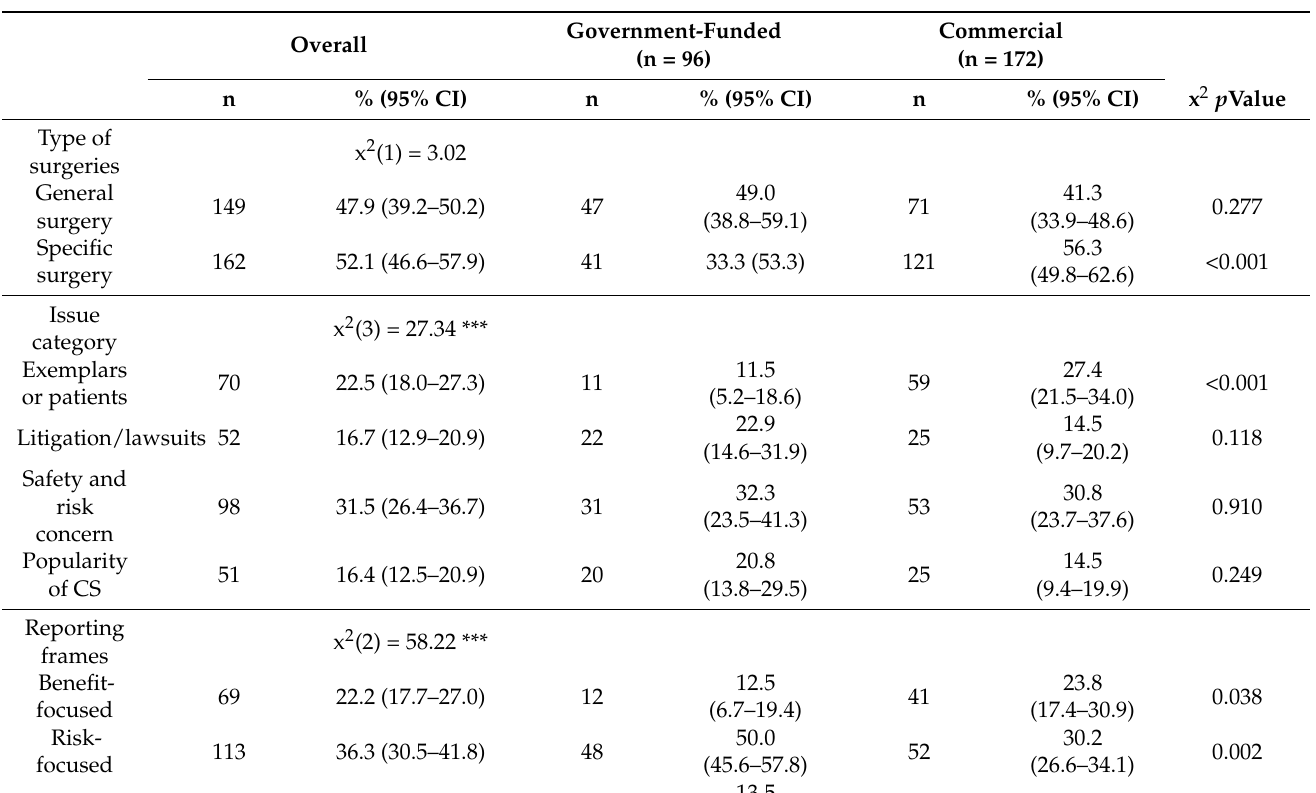
Table 1. Newspaper reporting on evidence, definition, etiology, causes, and consequences of cosmetic surgery, overall and by newspaper